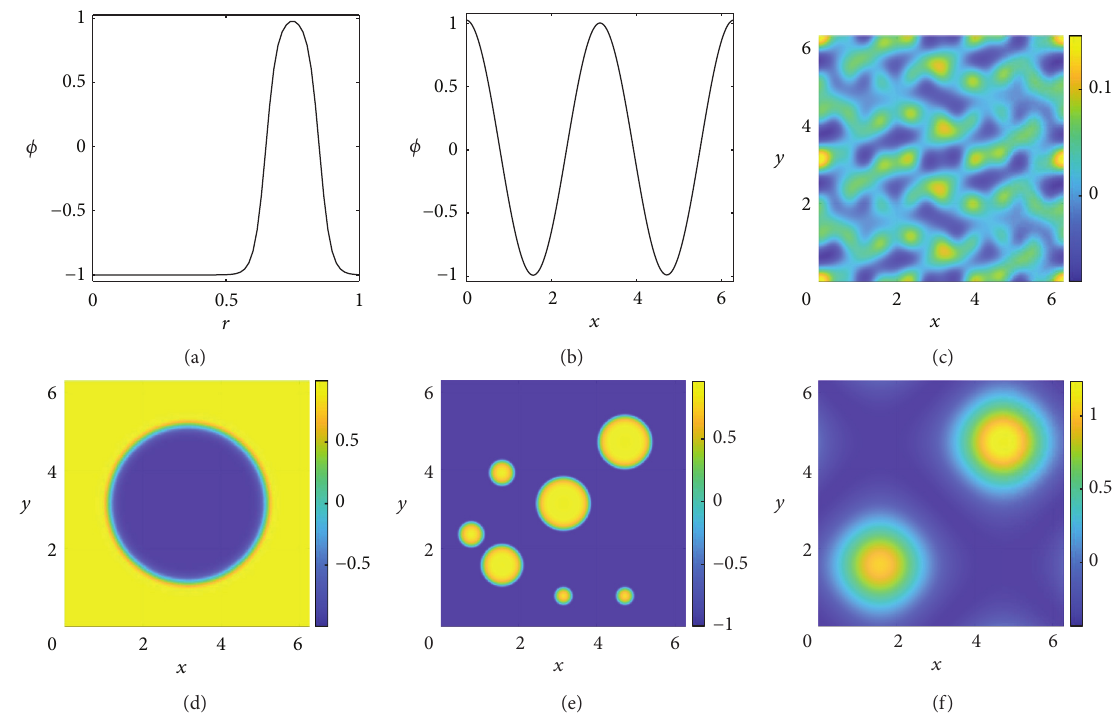
Figure 1: (a–f) The different initial conditions for benchmark problems from equations (3) to (8),